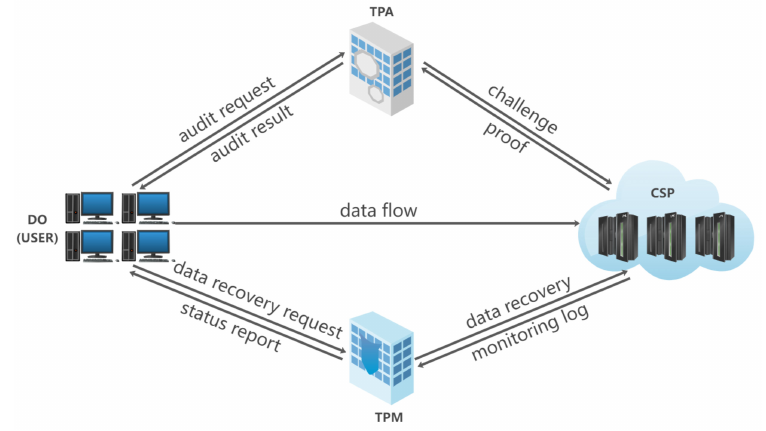
Figure 1. System model of the